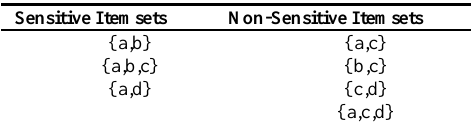
Table 3. Sensitive and non-sensitive itemsets.